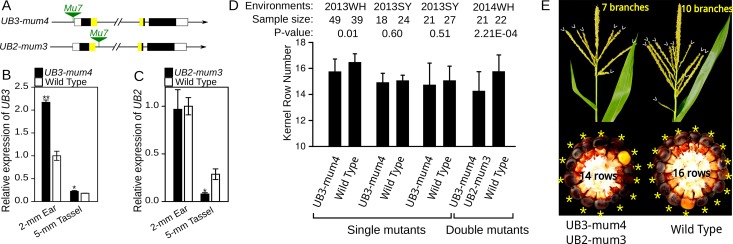
Expression analysis and phenotypic characterization of UB3-mum4 and UB2-mum3 mutants.A) The insertion site of Mutator in UB3-mum4 and UB2-mum3 mutants. B and C) Expression level of UB3 (B) and UB2 (C) in mutant and wild type. ** P < 0.01, * P < 0.05. D) KRN performance single and double mutants of UB3-mum4/UB2-mum3 and wild type; WH: Wuhan; SY: Sanya. E) Tassel and ear of wild type and double mutant of UB3-mum4/UB2-mum3. Detailed information regarding phenotypes is presented in S3–S6 Tables.